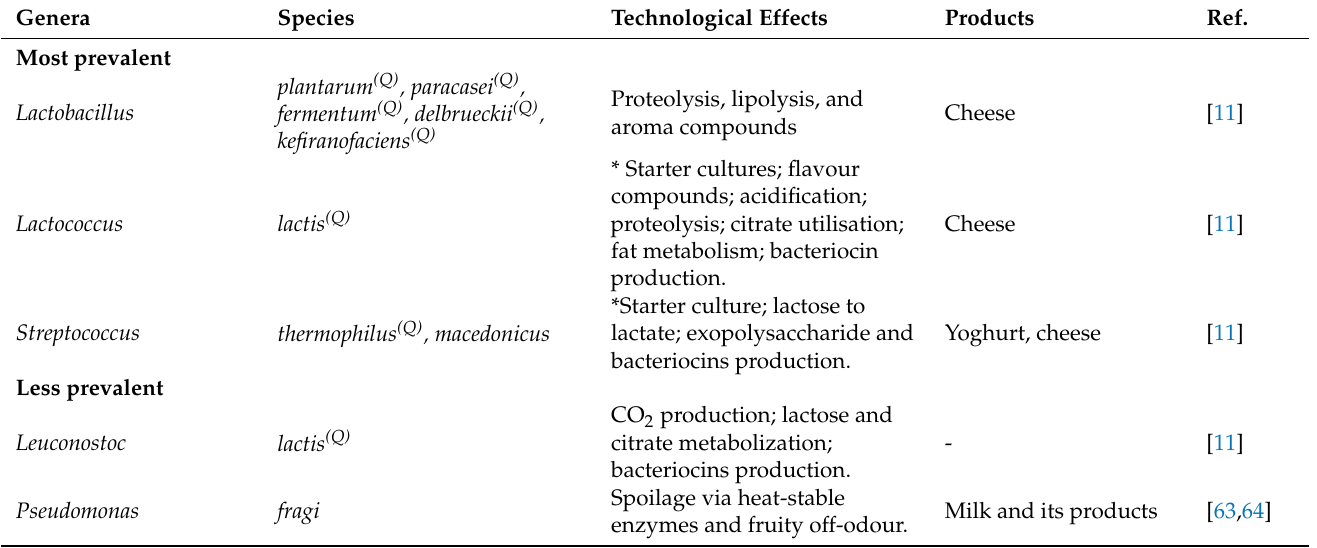
Table 3. Main microorganisms isolated in raw milk of buffalo ( Bubalus bubalis ) with probiotic and/or technological properties in dairy